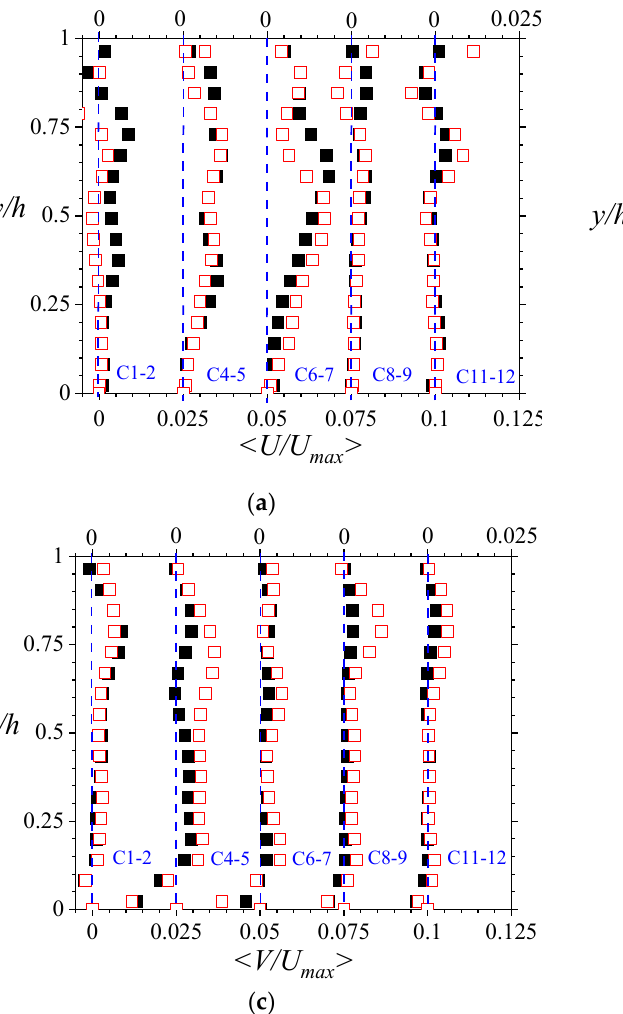
Figure 3. Parameters < U/U max > and < V/U max > are respectively line-averaged streamwise and wall-normal components of the mean velocity normalized by the maximum localline-averaged streamwise mean velocity in both open and porous regions. Here, the profiles for the flow within the porous medium are shown. Staggered plots ( a , c ) show the streamwise variations whereas ( b , d ) demonstrate the spanwise variations. The denominations C and R respectively stand for columns and rows, and are illustrated in Figure 1. Black-filled boxes are the results for Test A , and red-open boxes are the results for Test B .